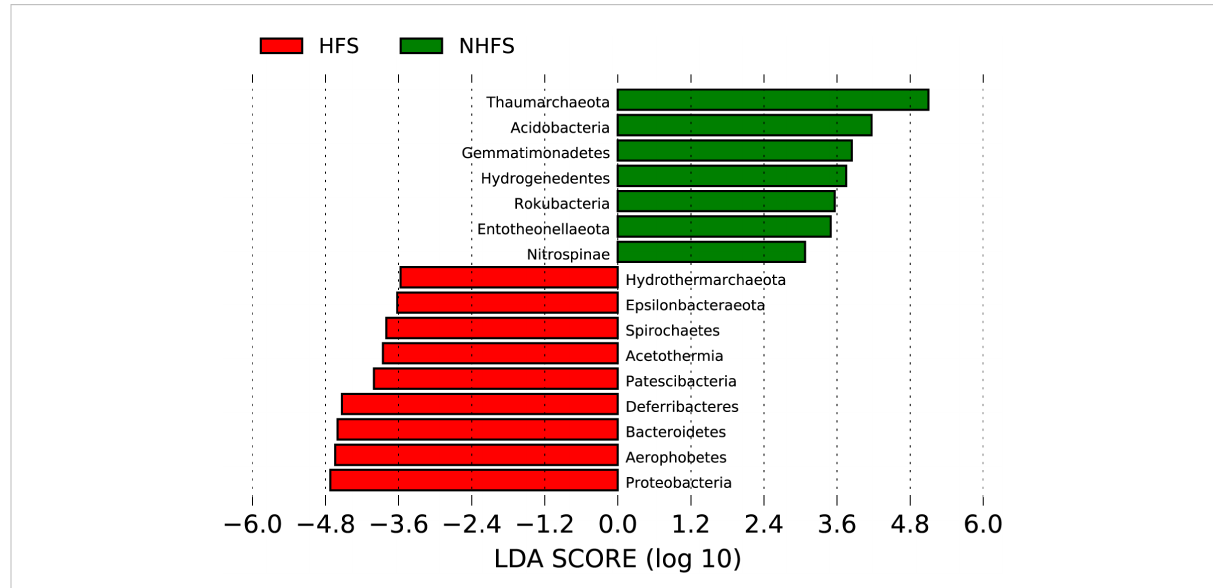
FIGURE 4 Taxonomic representation of the statistical differences at the phylum level between the prokaryotic communities in HFSs and NHFSs. The differential phyla in the histogram were ranked by effect size with an LDA threshold of